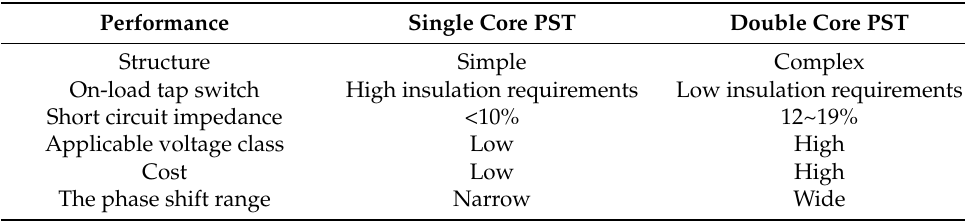
Table 1. Comparison of single core PST and double core PST.